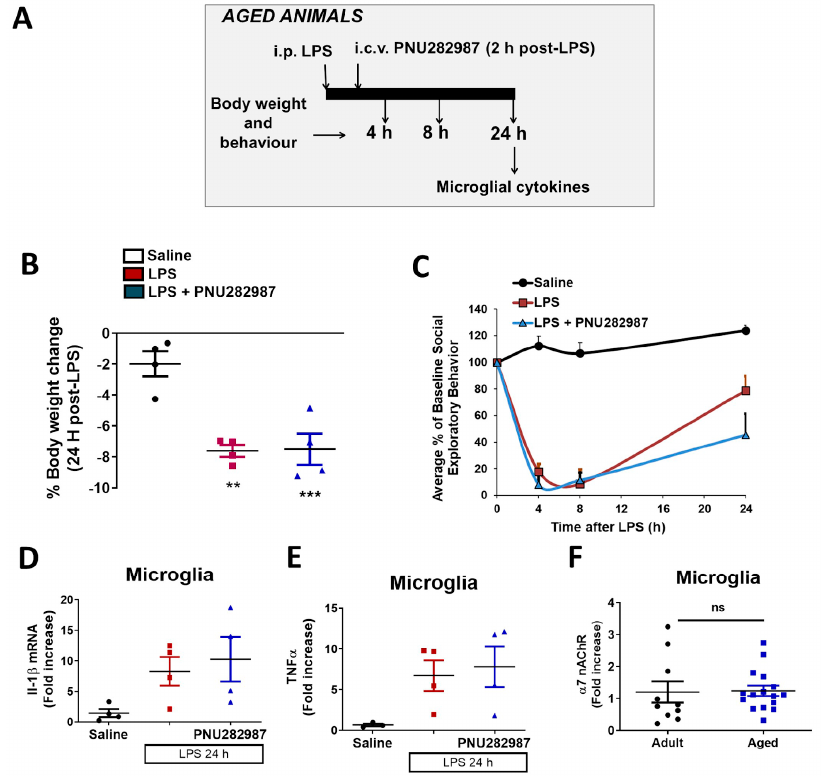
Figure 5. Central activation of α 7 nAChRs loses its anti-neuroinflammatory properties in aged mice. ( A ) Experimental protocol used. Aged (18–20 months old) Balb/c mice were injected i.p. with LPS 0.33 mg/kg ± i.c.v. PNU282987 (10 µ g) 2 h post-LPS. ( B ) Body weight change, ( C ) social exploratory behavior; measured 4, 8 and 24 h post saline/LPS injection. Microglial mRNA levels of IL-1 β ( D ) and TNF α ( E ) 24 h post-treatments (saline, LPS or LPS + PNU282987). ( F ) Levels of α 7 nAChR mRNA in adults and aged animals. Data correspond to the mean and S.E.M of 4 animals per group. Comparisons were made using one-way ANOVA ( D , E ) and two-ways ANOVA ( B , C ). ** p < 0.01, *** p < 0.001.